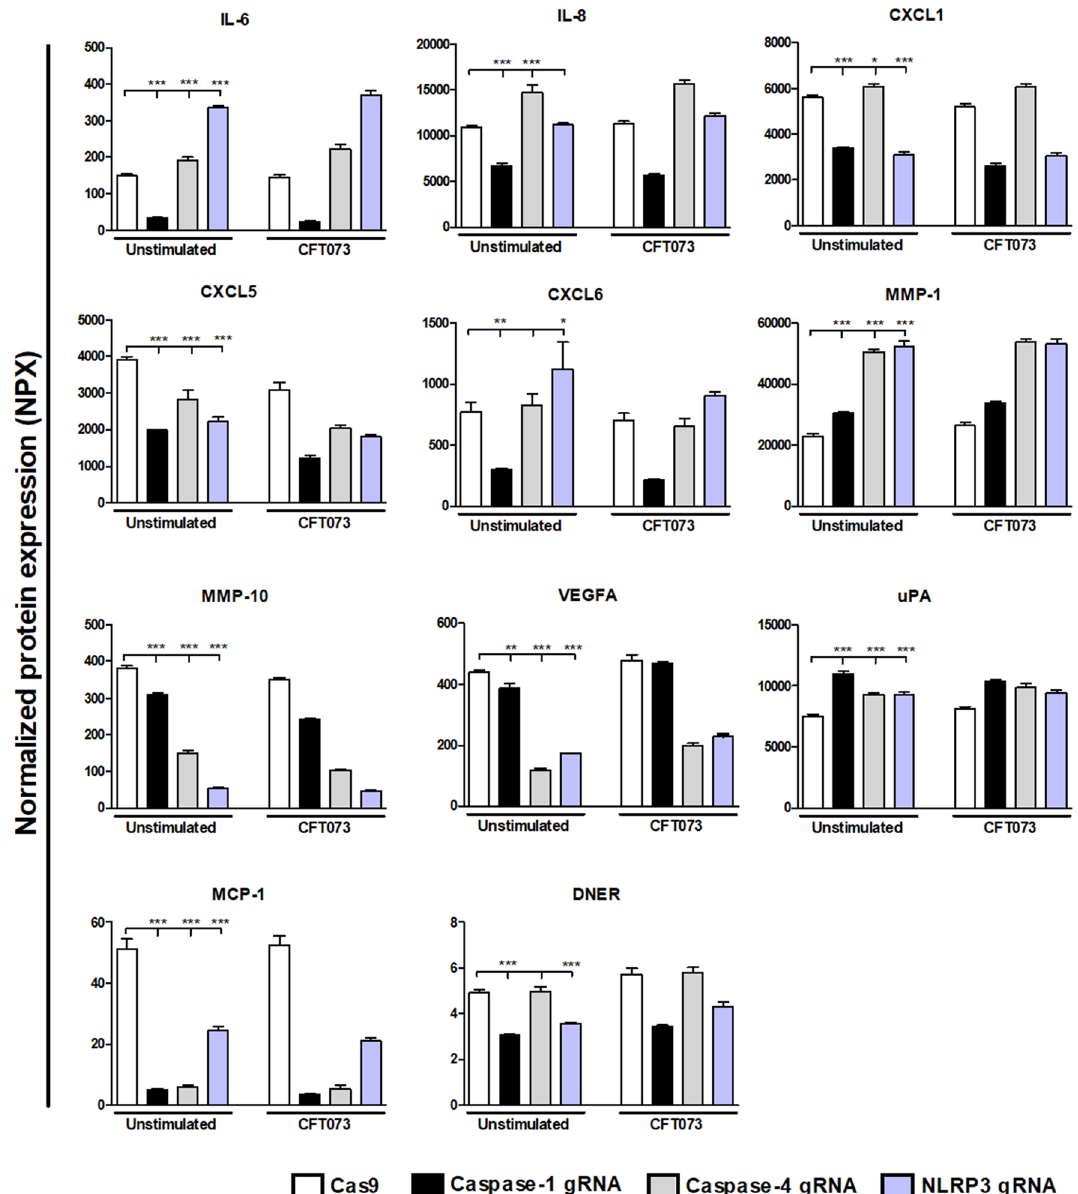
Figure 4. Targeted protein analysis of basal protein expression from bladder epithelial cells knockdown in caspase-1, caspase-4 or NLPR3. Caspase-1, caspase-4 and NLRP3-knockdown bladder epithelial cells and Cas9 controls were infected with CFT073 followed by analysis of protein expression using a panel of inflammation-related proteins. The basal protein expression was either significantly increased or decreased compared to Cas9 controls. The protein data is presented as normalized protein expression (NPX). gRNA stands for guideRNA targeting specific gene using CRISPR/Cas9. Data are presented as mean ± SEM of three independent experiments. Asterisks show statistical significance compared to Cas9 controls (* p < 0.05, ** p < 0.01, *** p <